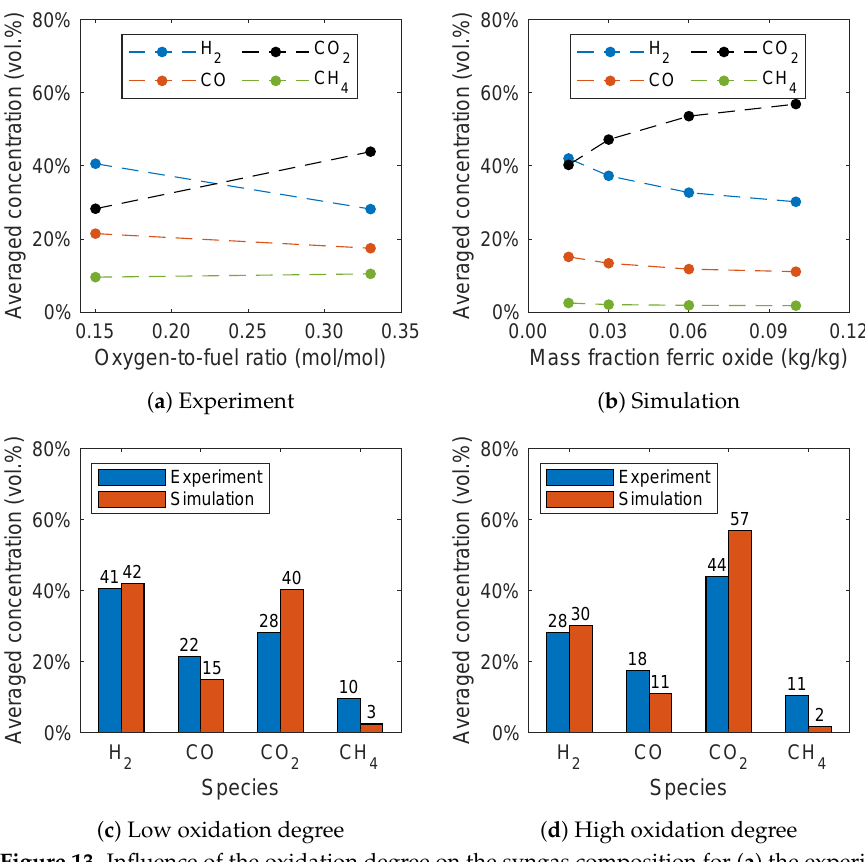
Figure 13. Influence of the oxidation degree on the syngas composition for ( a ) the experimental data given by Condori et al. [5] and ( b ) the simulation results. Comparison of the syngas composition for a ( c ) low and ( d ) high oxidation degree.